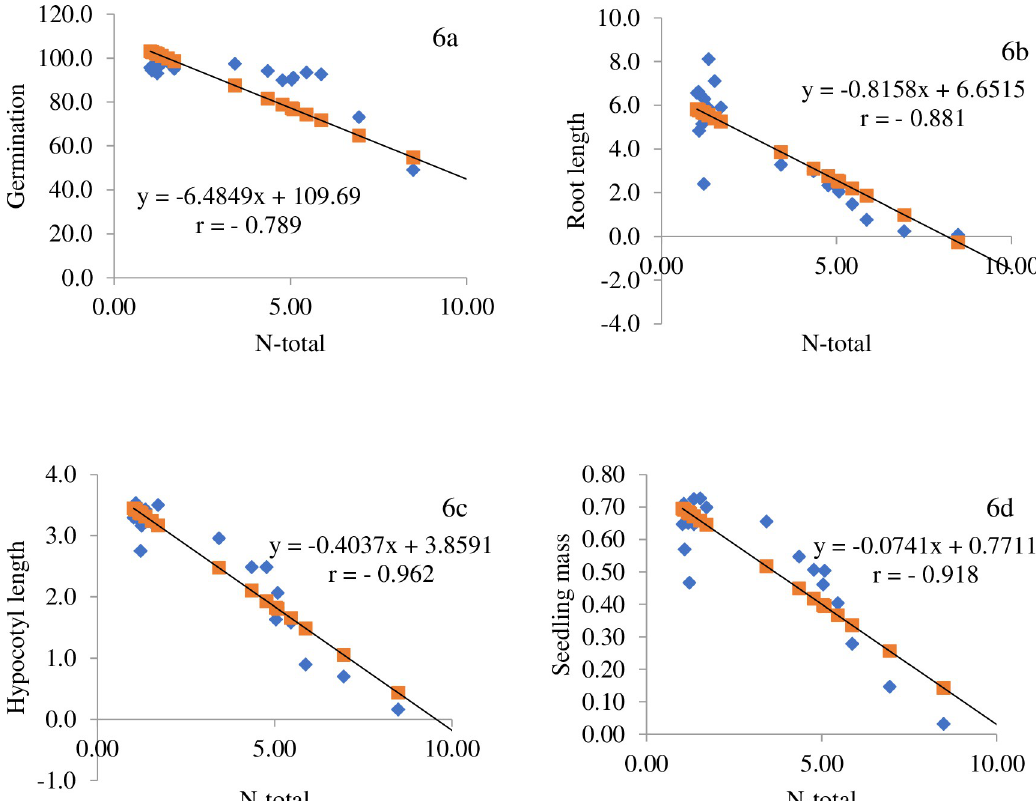
Fig 6. Effect on total N content on the germination capacity and seedling parameters of the tested plant Sinapis alba L.